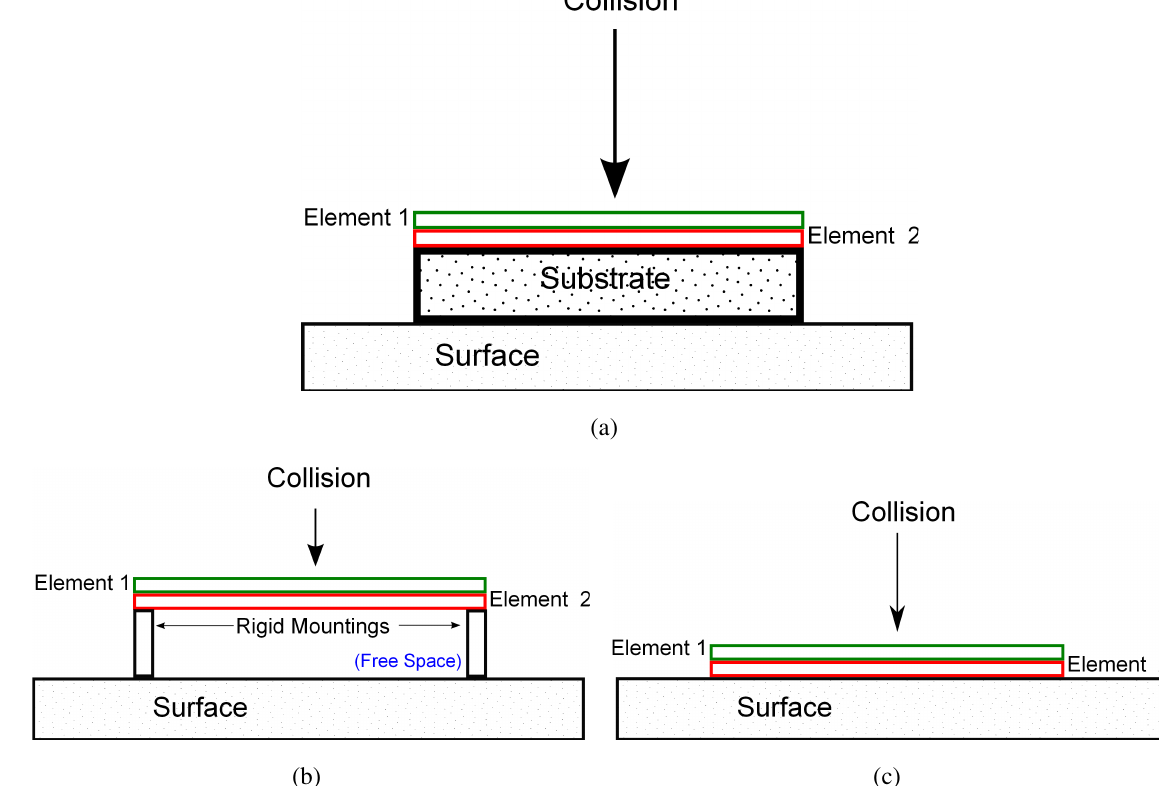
Figure 1. Sensor design diagrams. ( a ) Pseudo-membrane sensor construction; ( b ) Rigid construction; ( c ) Pressure